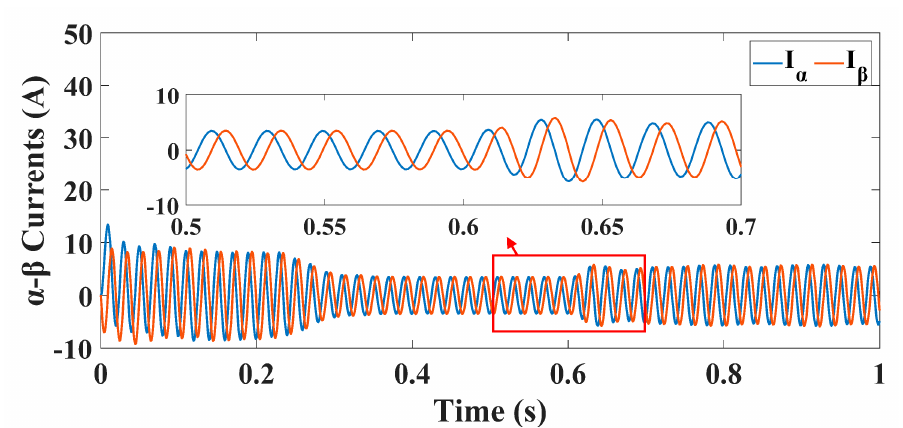
Figure 15. BRB-stator phase currents.